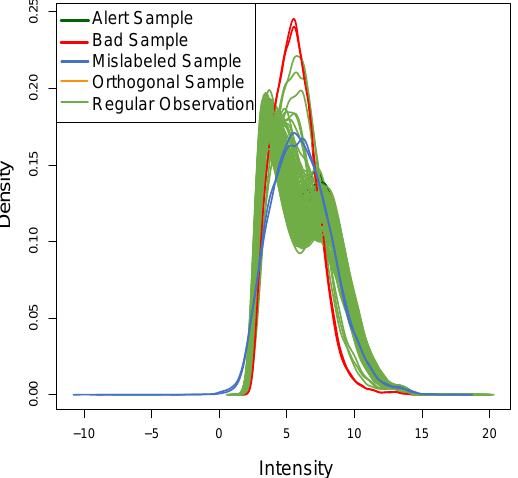
Figure 10. Density Plot of samples of Dataset A, grouped by classification.